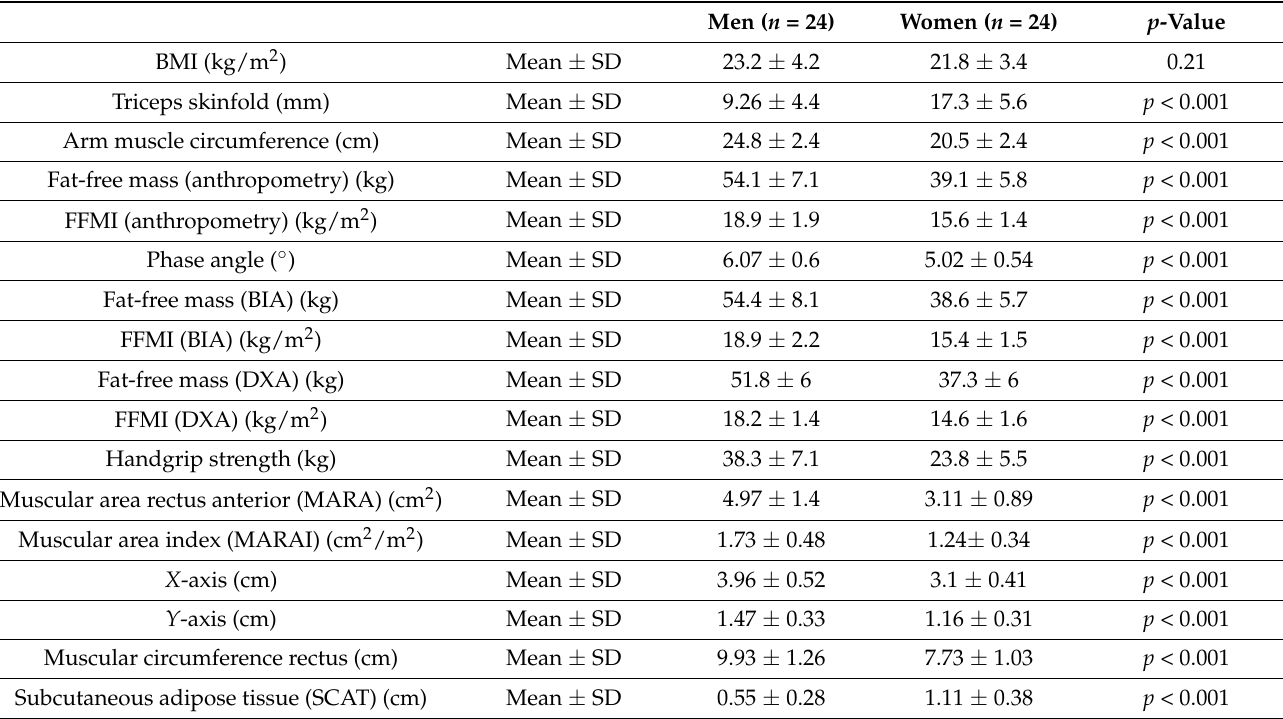
Table 2. Body composition parameters.